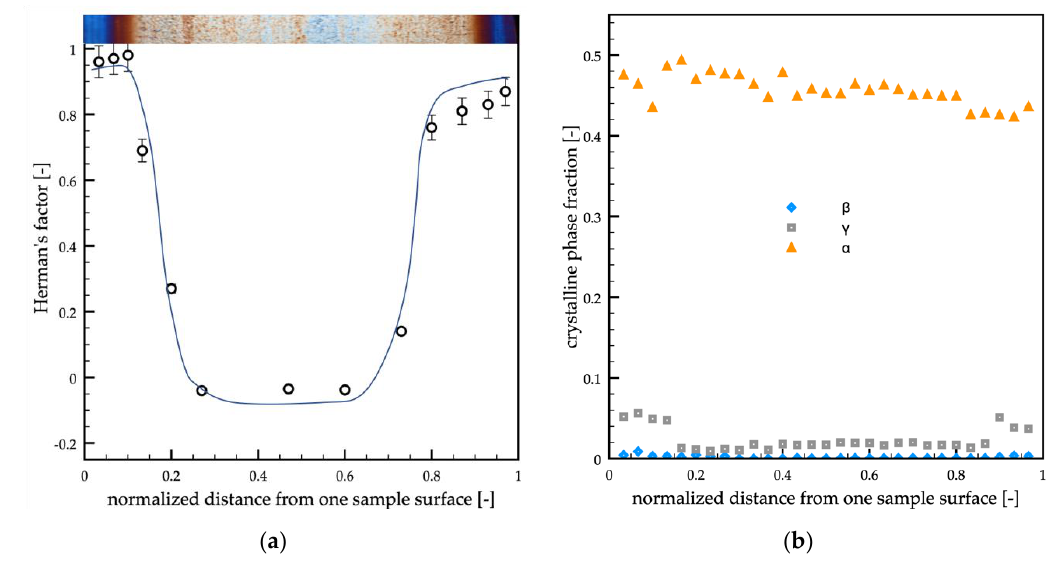
Figure 7. ( a ) WAXS analyses of the B molding in different positions along the sample thickness. Each analyzed position is indicated on the optical micrograph. The distribution of the orientation in terms of Herman’s factor was also reported. ( b ) Distributions of α, β, and γ-phase fractions along the sample thickness evaluated from the WAXS analyses.